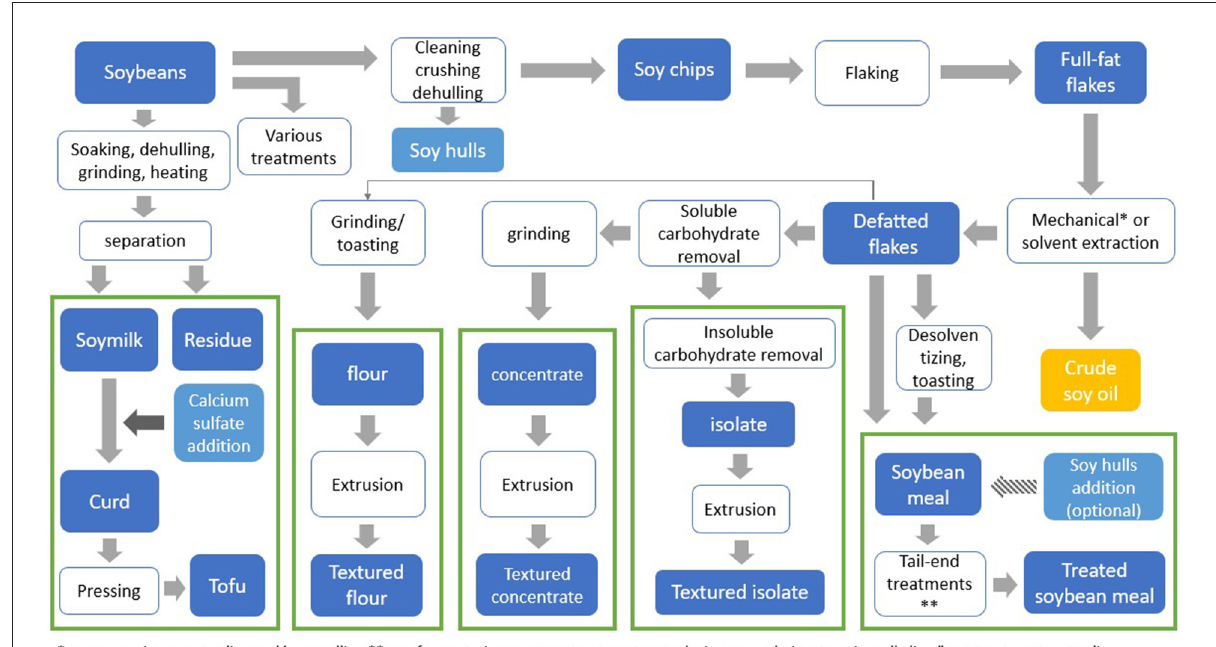
FIGURE1 Overview of soybean processing to obtain various soy products. *Mechanical pressing or extruding and/or expelling **e.g., fermentation, enzyme-treatment, autoclaving, oven drying, toasting, alkaline-heat-treatment,